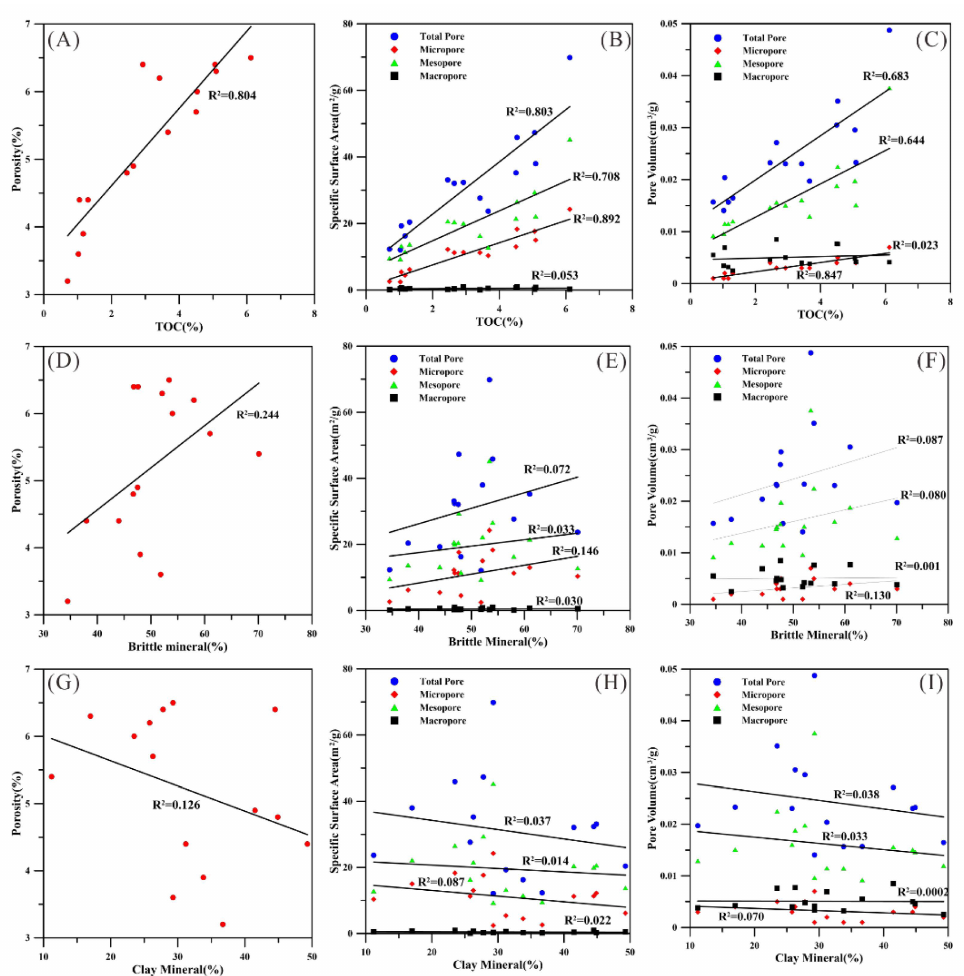
Figure 12. Relationship diagram of pore structure with mineral and TOC in Wufeng–Longmaxi Fm of Y108. ( A ) Correlation between TOC and porosity; ( B ) Correlation between TOC and specific surface area of different types of pores; ( C ) Correlation between TOC and pore volume of differ- ent types of pores; ( D ) Correlation between Brittle mineral and porosity; ( E ) Correlation between Brittle mineral and specific surface area of different types of pores; ( F ) Correlation between Brittle mineral and pore volume of different types of pores; ( G ) Correlation between Clay mineral and porosity; ( H ) Correlation between Clay mineral and specific surface area of different types of pores; ( I ) Correlation between Clay mineral and pore volume of different types of